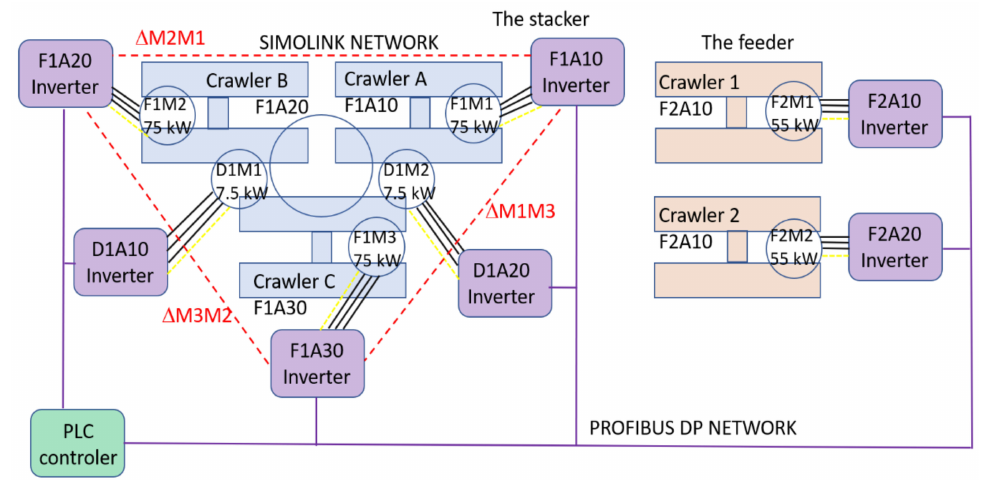
Figure 6. Block diagram of the electrotechnical drive system used in the stacker machine